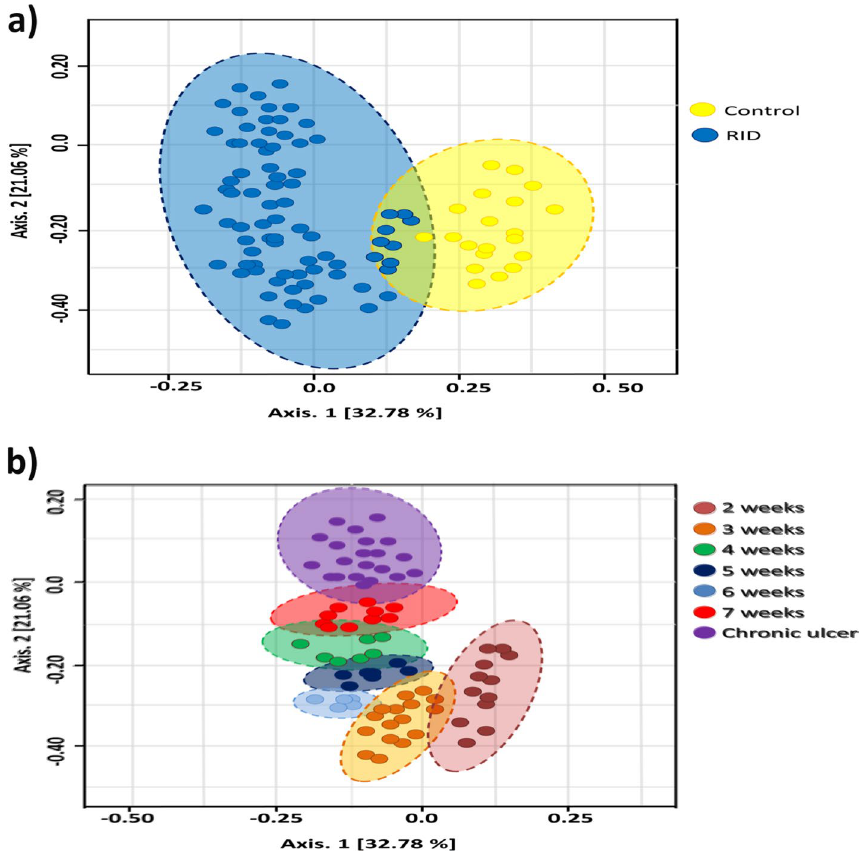
Figure 3. Principal coordinates analysis (PCoA) of cutaneous microbiomes based on weighted UniFrac distance matrices. PCoA plot represents the similarity distances between cutaneous microbiota of ( a ) healthy and diseased groups, ( b ) only RID microbiomes. Ellipses indicate the significant clustering (Adonis: r2 = 0.047, P = 0.00092) that was based on health state ( a ) and time required for healing ( b